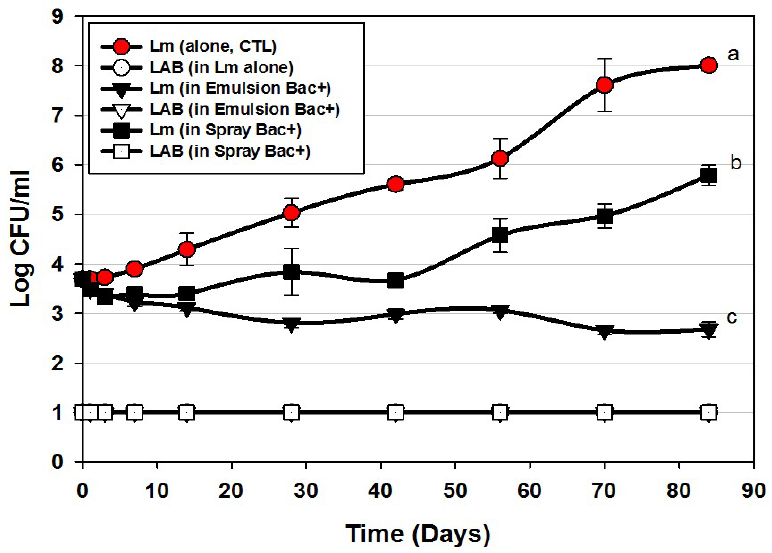
Figure 3. L. monocytogenes 39-2 challenge study on hotdogs with multiple MOA Bac + CFS held at 5 °C for up to 84 days in vacuum packages (Trial #2). L. monocytogenes 39-2 was inoculated onto untreated hotdogs (Lm, alone), inoculated onto hotdogs in which the bacteriocin mixture was mixed into the meat emulsion during manufacture (in emulsion Bac+), or inoculated onto hotdogs in which the bacteriocin mixture was previously sprayed while hotdogs were still in casings before peeling (in spray Bac+). The Bac + CFS was comprised of curvaticin FS47, curvaticin Beef3, pediocin Bac3, and lacticin FLS1. Platings for LAB from all treatments were made on acidified MRS (hollow symbols). All sample treatments were performed in triplicate replication; data points represent the means and error bars represent the standard deviation from the means. Treatments with different letters are significantly different (repeated measures, p < 0.05).